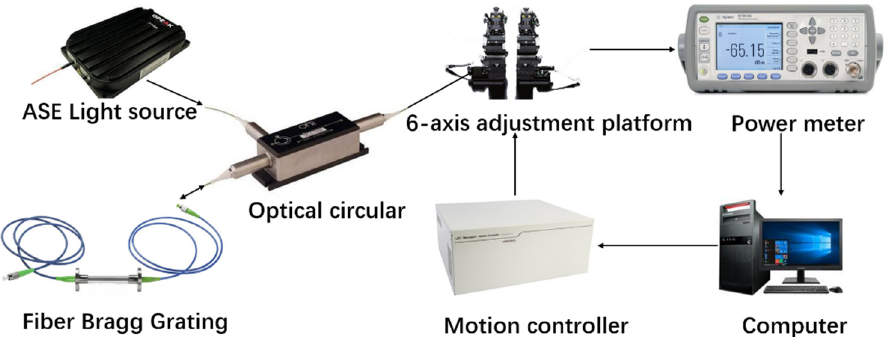
Figure 11. Testing system for the interrogation performance measurement of the fabricated AWG.